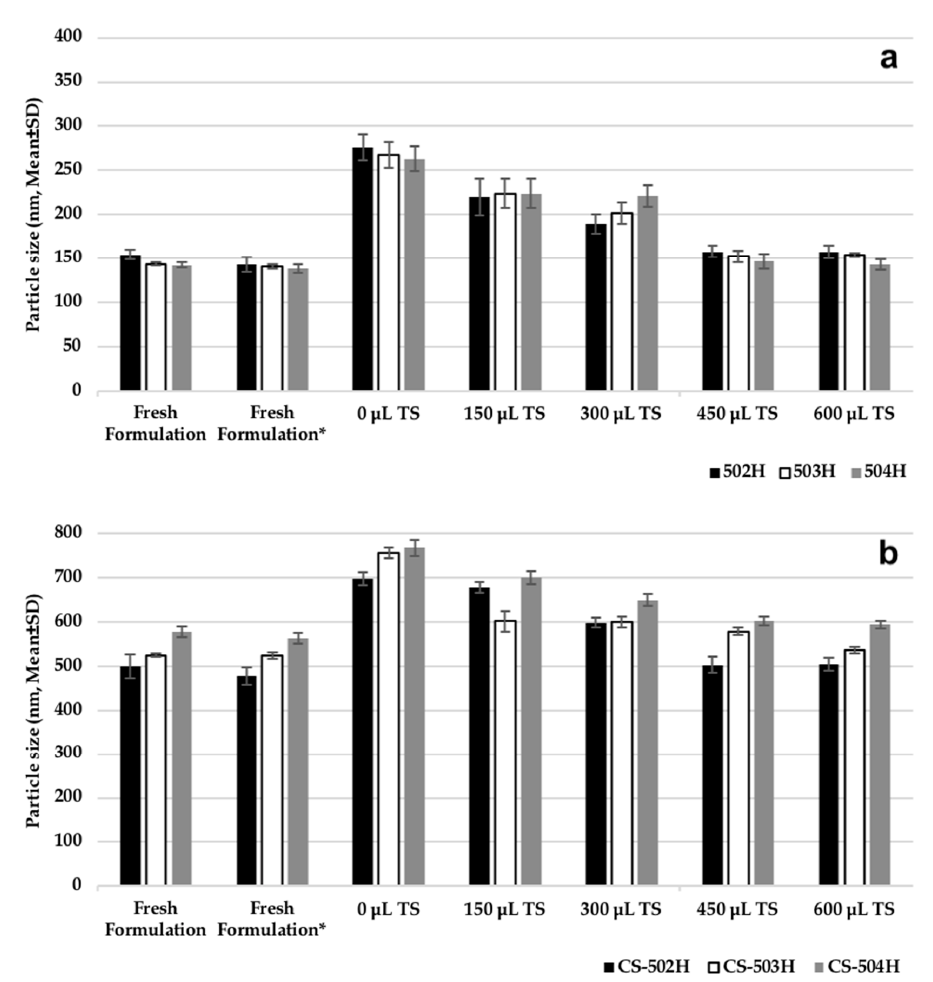
Figure 2. Effect of cryoprotectant on particle size of nanoparticles prepared; ( a ) PLGA nanoparticles (NPs), ( b ) chitosan-coated PLGA NPs. *: Fresh formulation after centrifugation and dispersing in 1 mL trehalose solution (5% w / v ).